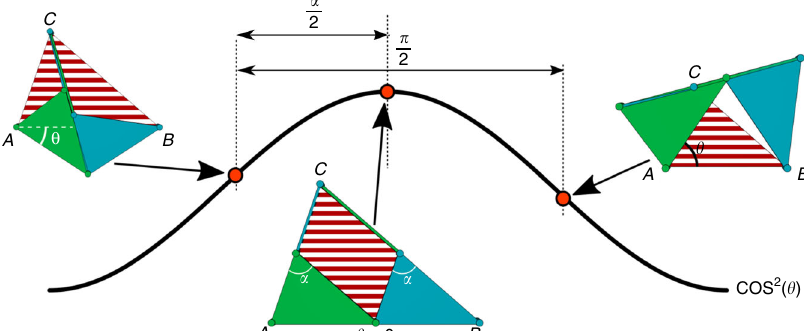
Fig. 5 Range of motion of the skew pantograph. The limits of scaling of a skew pantograph. The area of the spanned triangle (shown as a red-striped area) scales with cos 2 ð θ Þ . The red dots illustrate the values of θ in each of the drawings. The end of motion is reached when the bars of the linkage become collinear (left and right drawings). Between these states, the rotation angle of θ is always π . The distribution of this range over the left and right 2